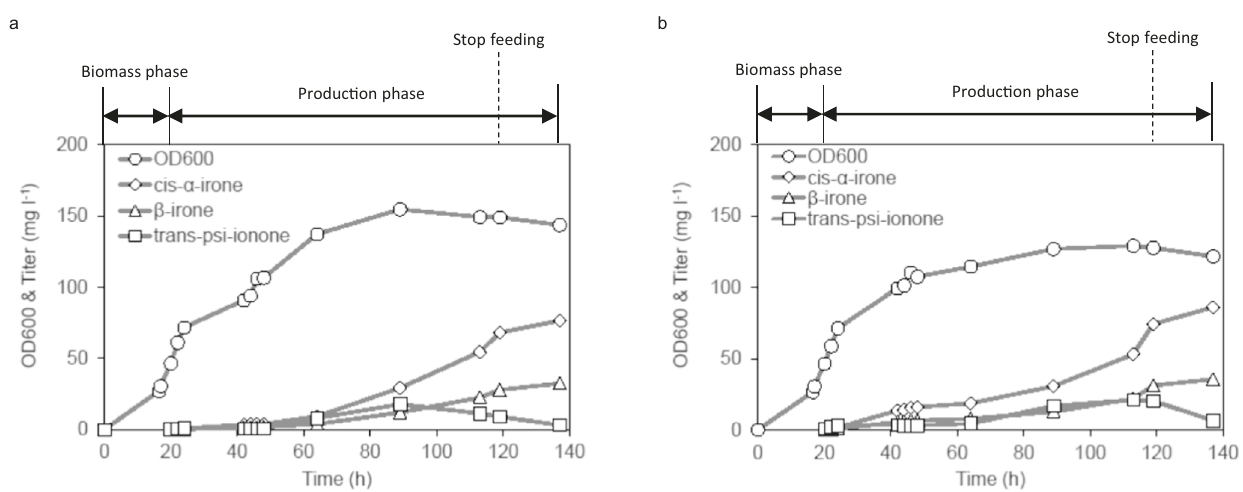
Fig. 5 | Fed-batch process of cis- α -irone. Time-course pro fi les of OD 600 , cis- α - irone, β -ironeandpsi-iononetitreswhen a DOwascontrolledat2%. b whenDOwas controlled at 10% during the production phase. For both bioprocesses, the